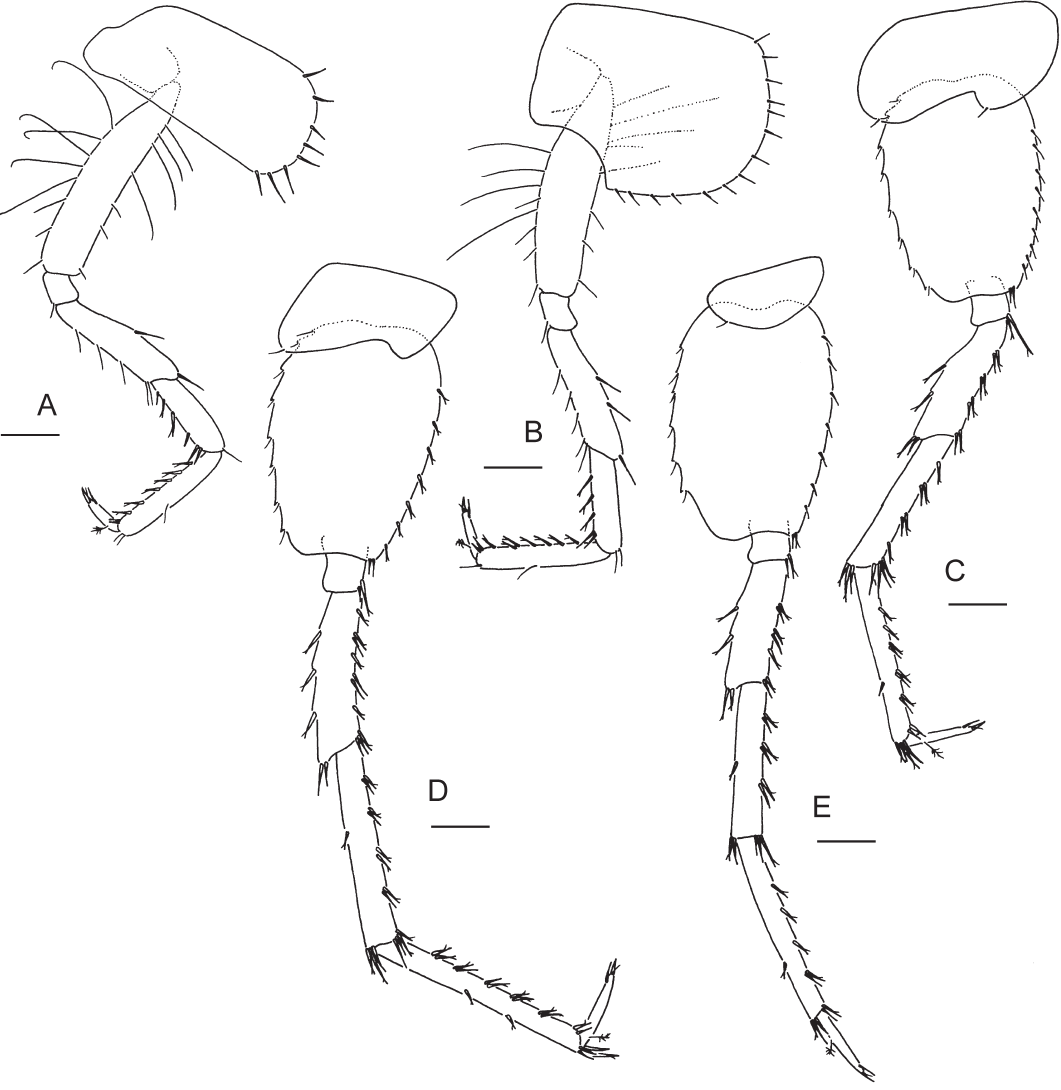
Fig. 5A-E. Synurella ambulans (F. Müller, 1846), ♂, 4.5 mm, FENU X34906/Cr-1406, MO. A . Pereopod 3. B . Pereopod 4. C . Pereopod 5. D . Pereopod 6. E . Pereopod 7. Scale bars 0.2